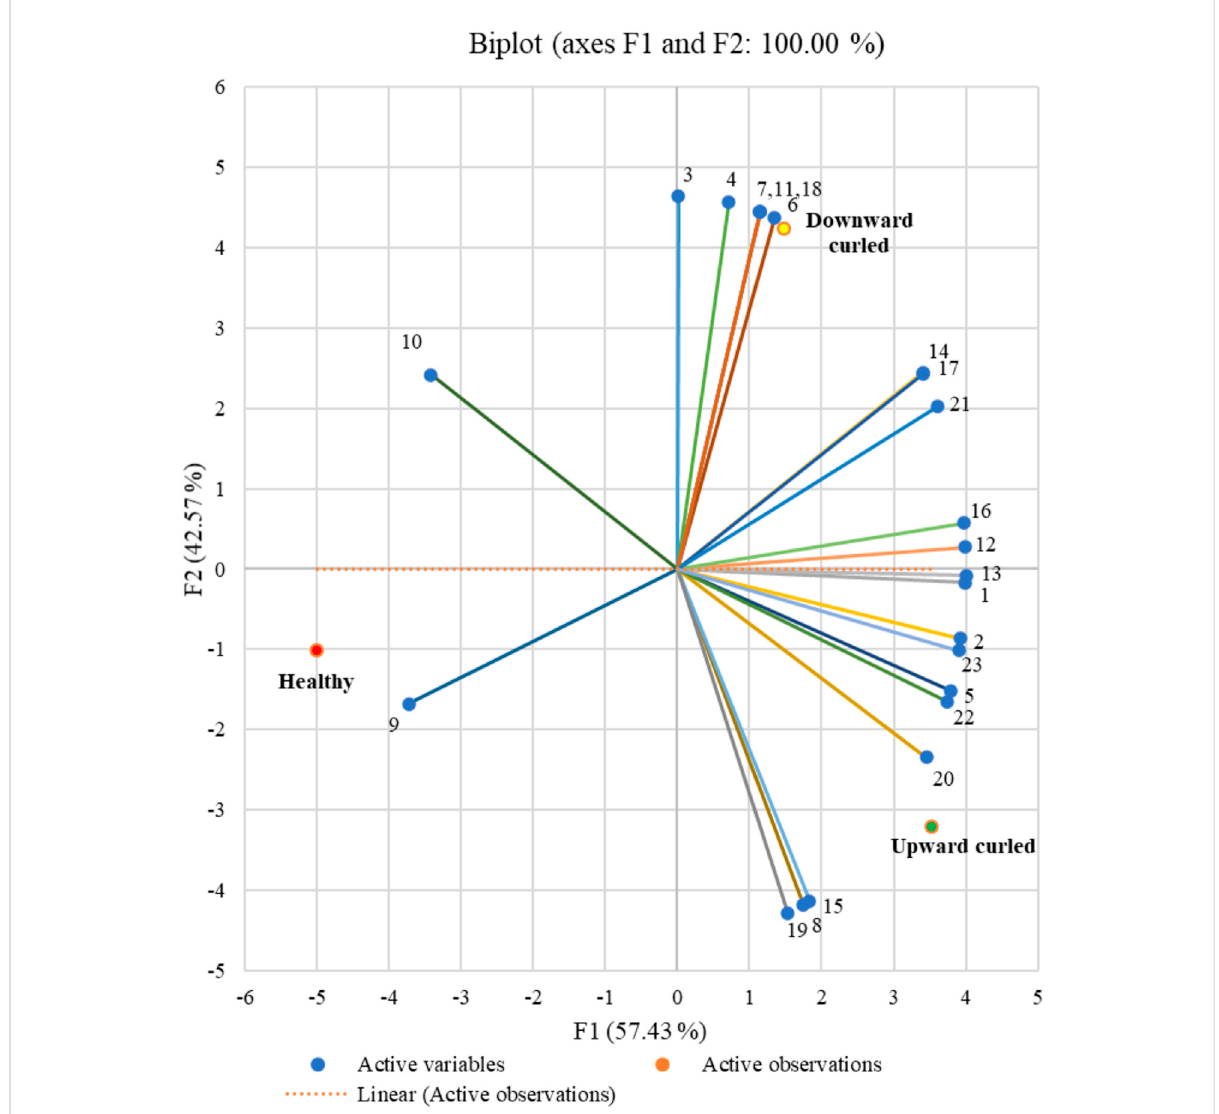
FIGURE 5 Biplot represents the relationship between different infection stages and volatile emission. The horizontal axis denotes the fi rst PCA dimension representing the upward curled stage, while, the vertical axis denotes the second dimension representing the downward curled stage. Though